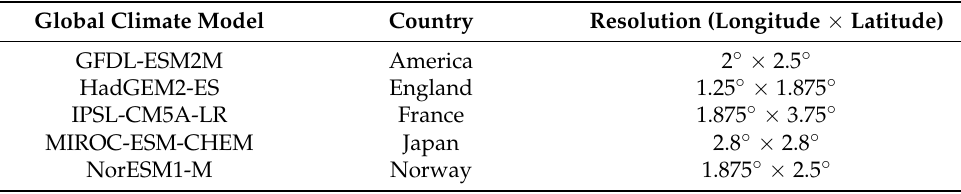
Figure 1. The location of hydrological and meteorological stations in and around the Yellow River Basin. Table 1. The basic information of the five global climate